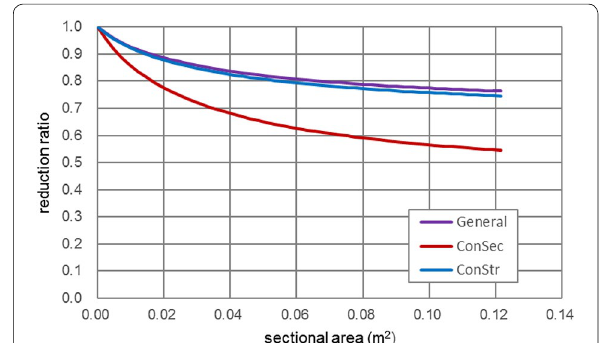
Fig. 3 Relation between sectional area of the outrigger and reduction ratio.